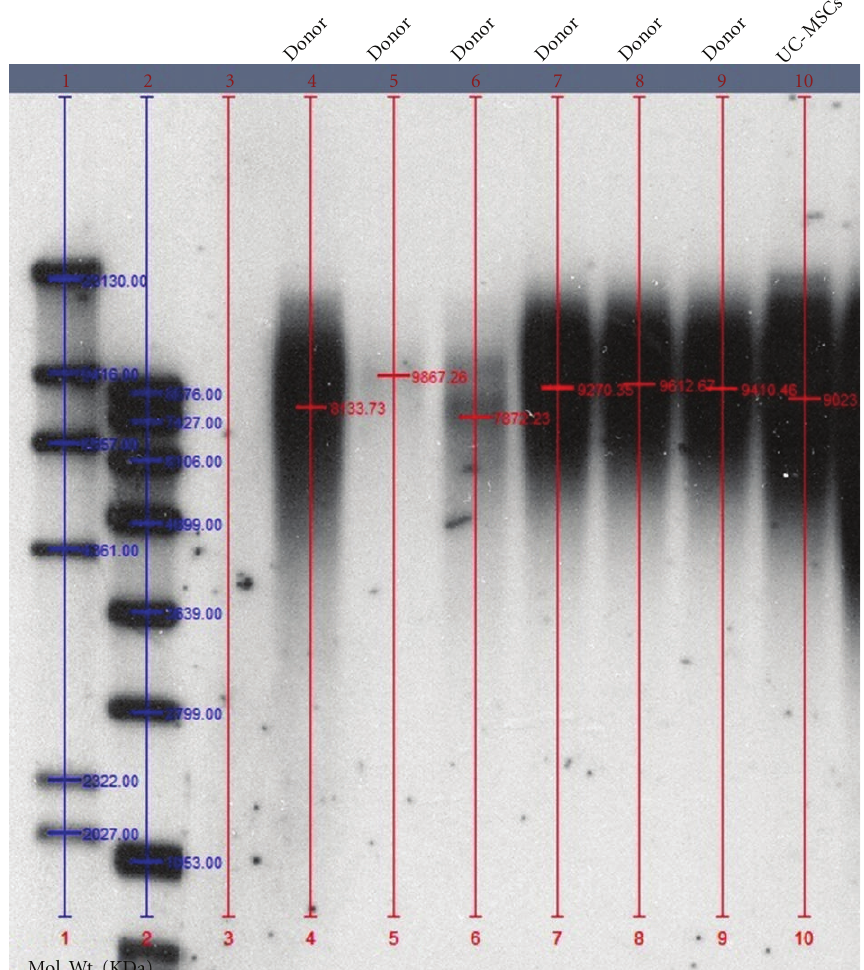
Figure 8: Telomere length of UC-MSCs compared to telomere length of BM-MSCs from 6 di ff erent donors (age 20–30) as assayed by Southern Blot analysis of DNA restriction